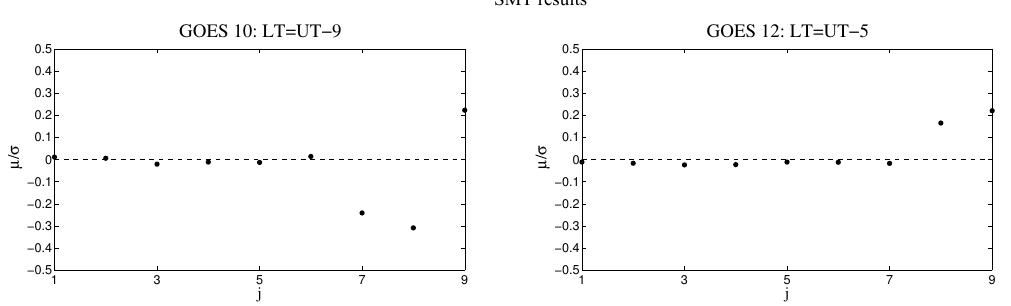
Figure 7. SSQ, 10–12 October 2003: SMT applied to the EMD reconstruction of the magnetospheric observations for GOES10 (left panel) and GOES12 (right panel) B z components. The x axis is order in terms of the last mode involved in the partial sums (see Eq. 8).